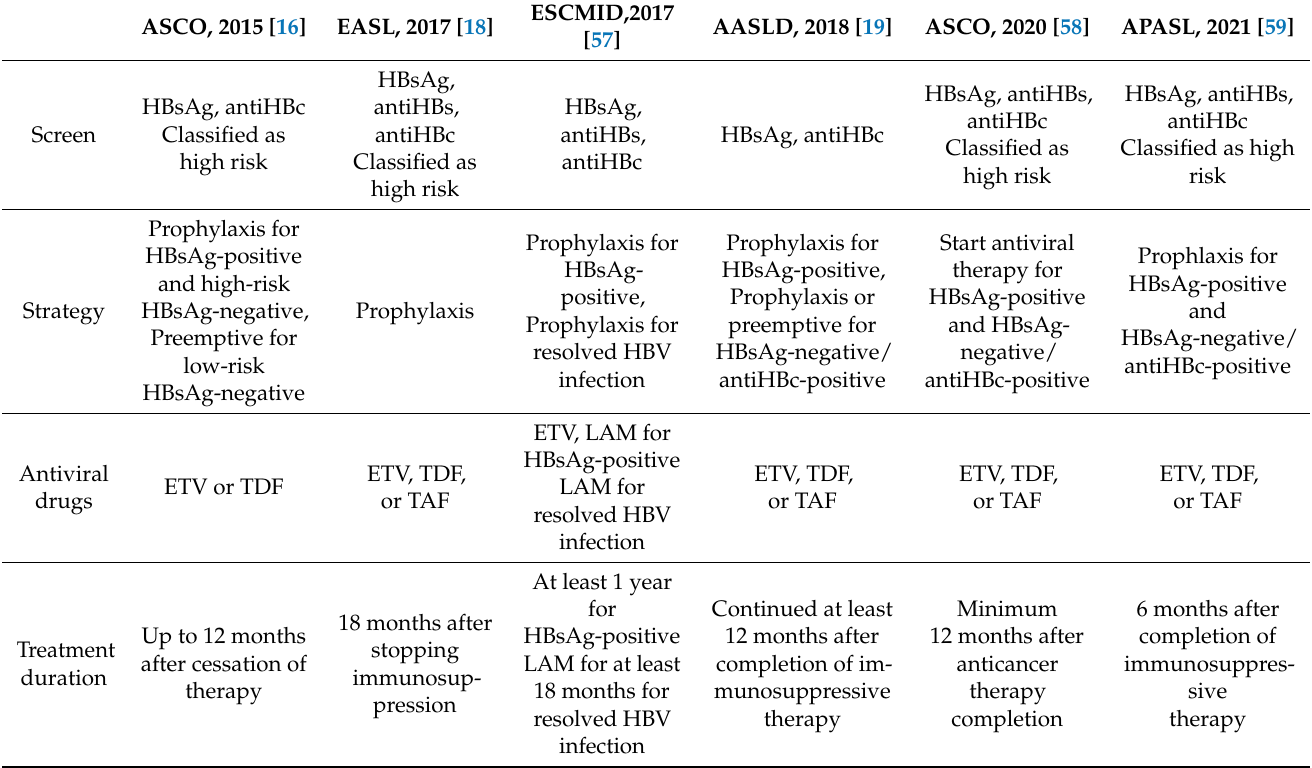
Abbreviations: 3TC, lamivudine; AASLD, American Association for the Study of Liver Diseases; APASL, Asian-Pacific Association for the study of the liver, ASCO, American Society of Clinical Oncology; EASL, European Association for the Study of the Liver; ESCMID, European Society of Clinical Microbiology and Infectious Diseases, ETV, entecavir; HSCT, hematopoietic stem cell transplantation; TAF, tenofovir alafenamide; TDF, tenofovir disoproxil